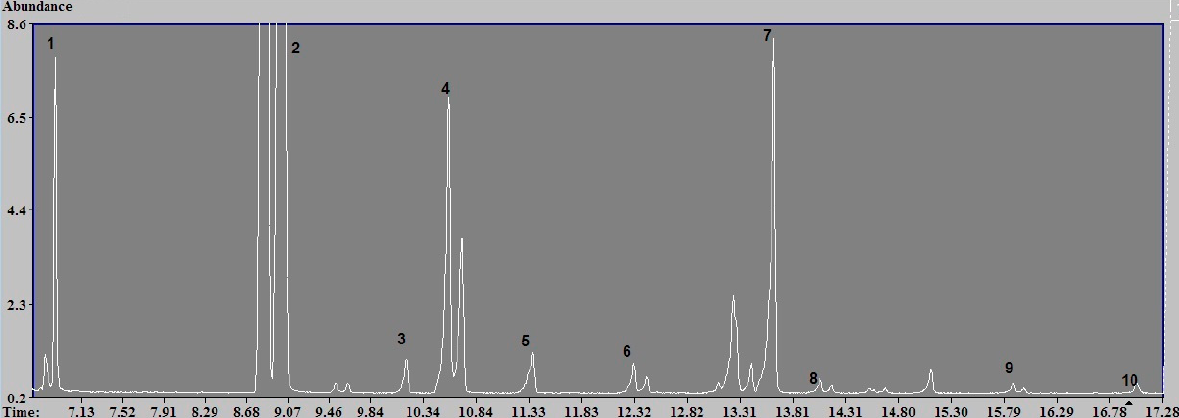
Figure 3. Chromatogram of derivatized aldehydes PFBHA. Identified components: (1) formaldehyde, (2) acetaldehyde, (3) acetone, (4) propionic aldehyde, (5) isobutyl aldehyde, (6) butyl aldehyde, (7) diacetyl, (8) valerian aldehyde, (9) hexanal, and (10) furfural.